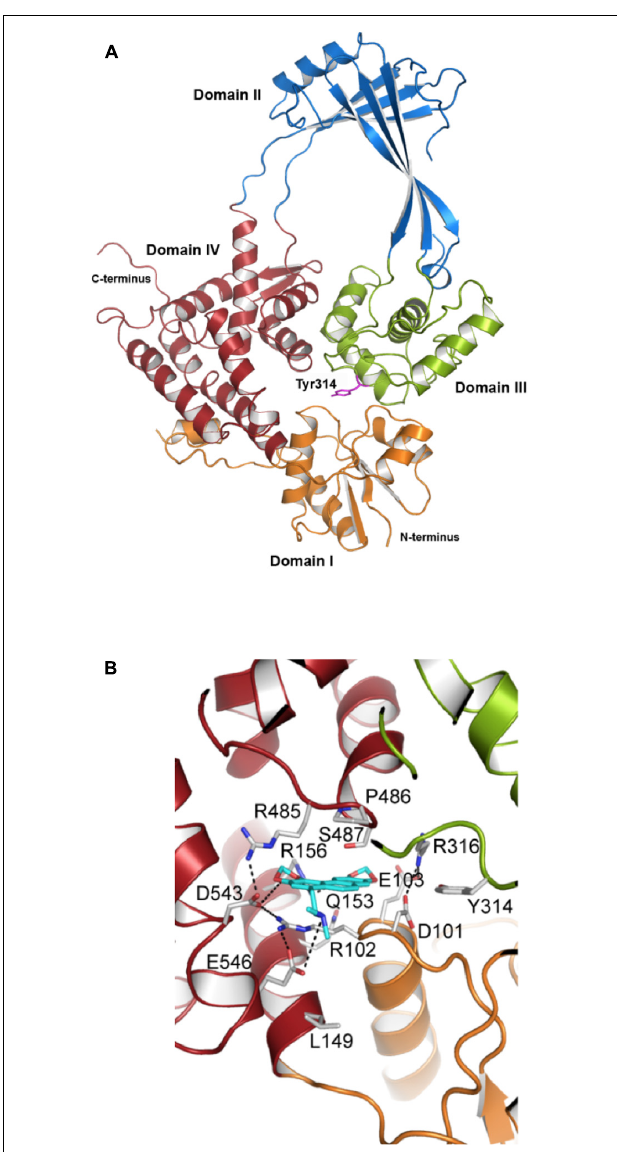
FIGURE 6 | Structural modeling of the interaction of N -methyl SCN with S. pneumoniae topoisomerase I. (A) Modeling of the 67 kDa fragment of Topo I, showing domains I–IV and the catalytic Tyr314. (B) N -methyl-SCN (in blue) bound to the nucleotide-binding site of Topo I. Hydrogen bonds and salt-bridge interactions are indicated by dashed lines. Taken from García et al. (2011), with